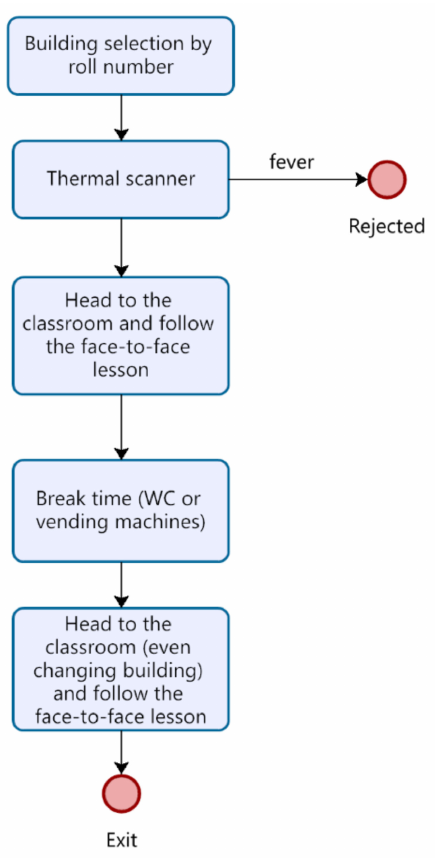
Figure 4. Flow chart regarding the student’s flow.